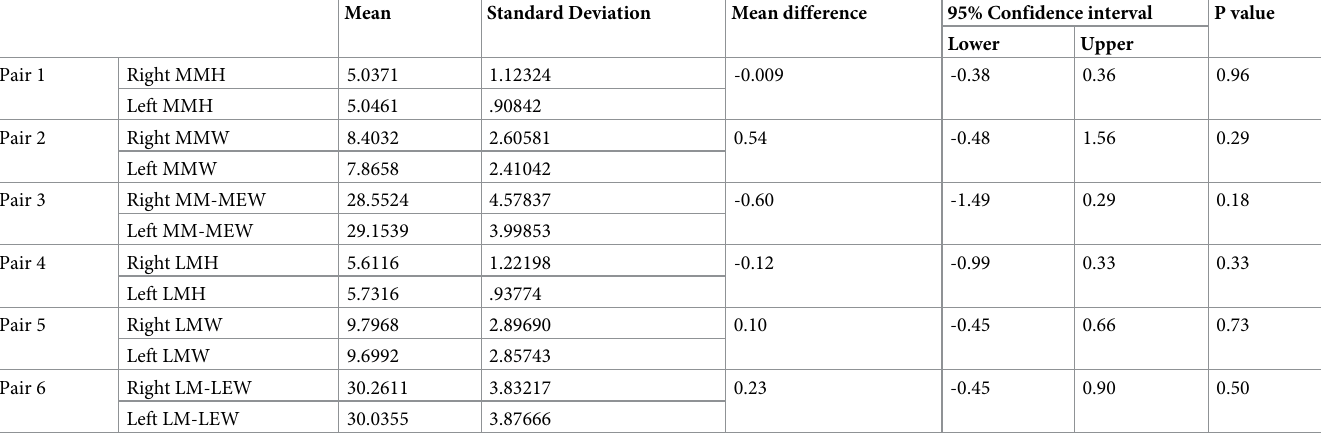
Table 1. Mean differences and the significance of the differences between left and right knee meniscal measurements in mid-coronal view. The minus sign here means that the left was more than the right. Mean